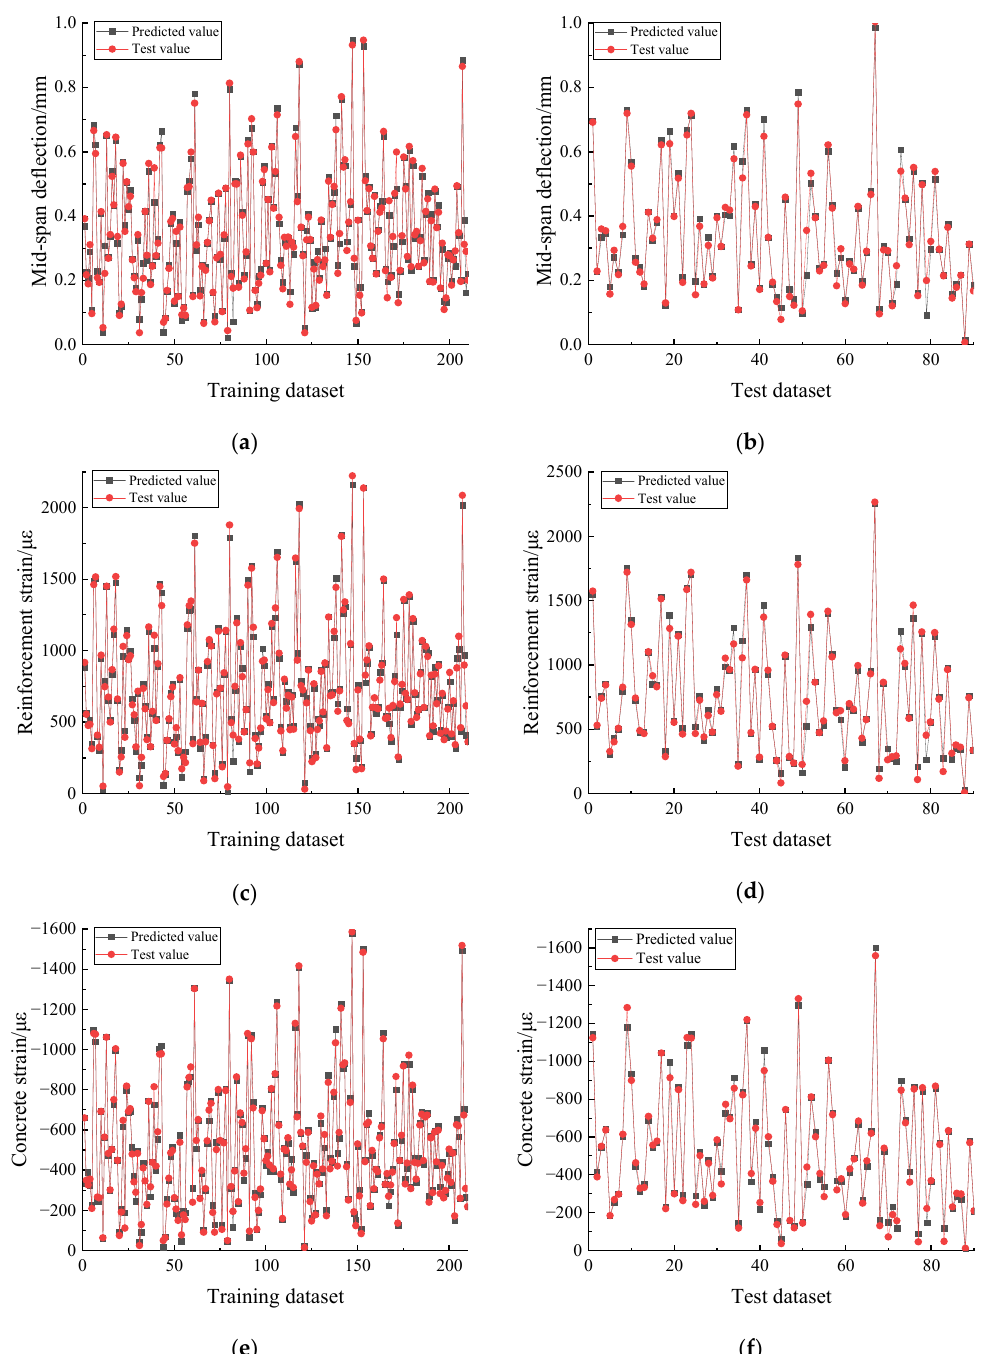
Figure 8. Comparison between predicted and experimental values of PSO-DBN model: ( a ) mid-span deflection prediction for training data; ( b ) mid-span deflection prediction for test data; ( c ) reinforce- ment strain prediction for training data; ( d ) reinforcement strain prediction for test data; ( e ) concrete strain prediction for training data; and ( f ) concrete strain prediction for test data. The regression plots of the two parts of the training set and the test set are shown in Figure 9. From Figure 9, it can be seen that the PSO-DBN model has a better prediction ability. For the training set, the coefficients of determination ( R 2 ) of the three output vec- tors are 0.983, 0.991, and 0.993, respectively. For the test set, the coefficients of determina- tion ( R 2 ) of the three output vectors are 0.979, 0.986, and 0.989, respectively. The coeffi- cients of determination of the three output vectors remain above 0.97 for both the training